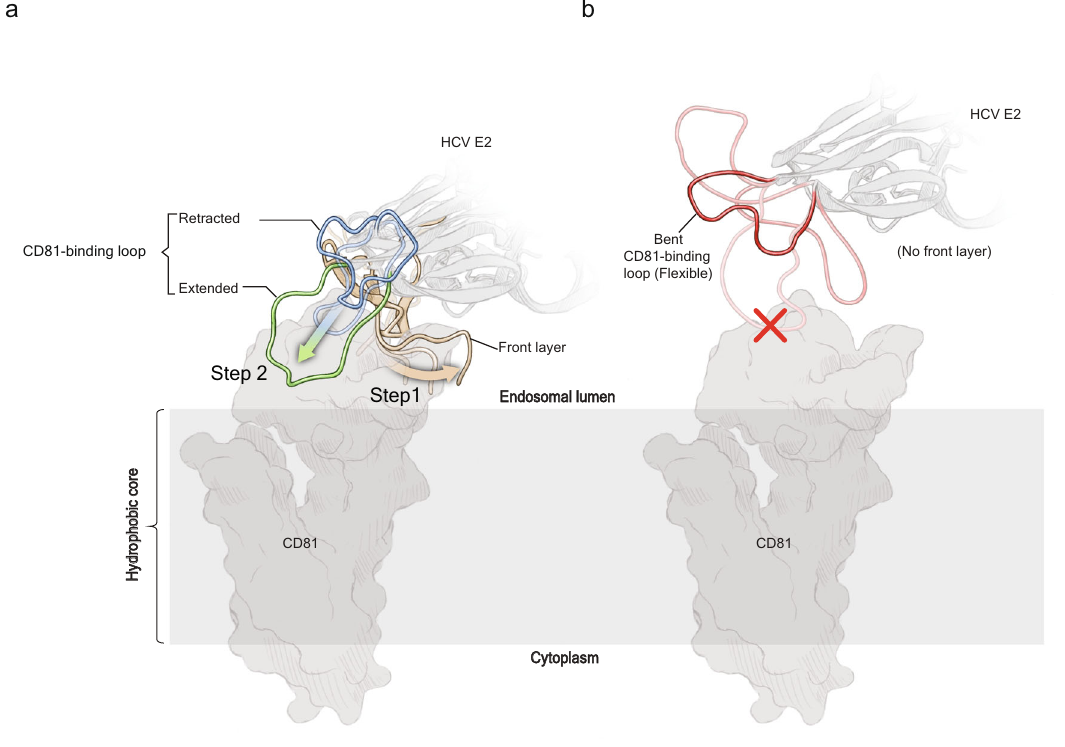
Fig. 7 | Schematic representation of HCV hybrid entry mechanism. a In the presence of CD81 and low pH, the front layer wraps around CD81 and then the CD81-binding loop extendsout toward the hostmembrane. b Deletionofthe front